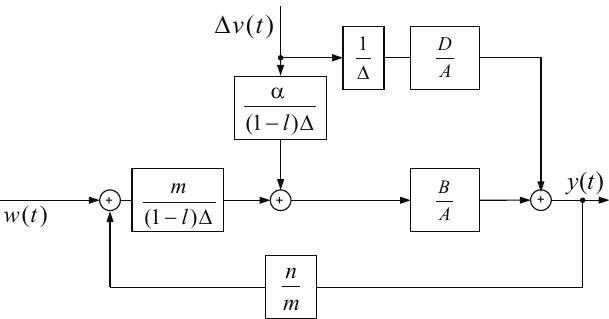
Figure 1. Generalized Predictive Control (GPC) resulting scheme for feedback and feedforward